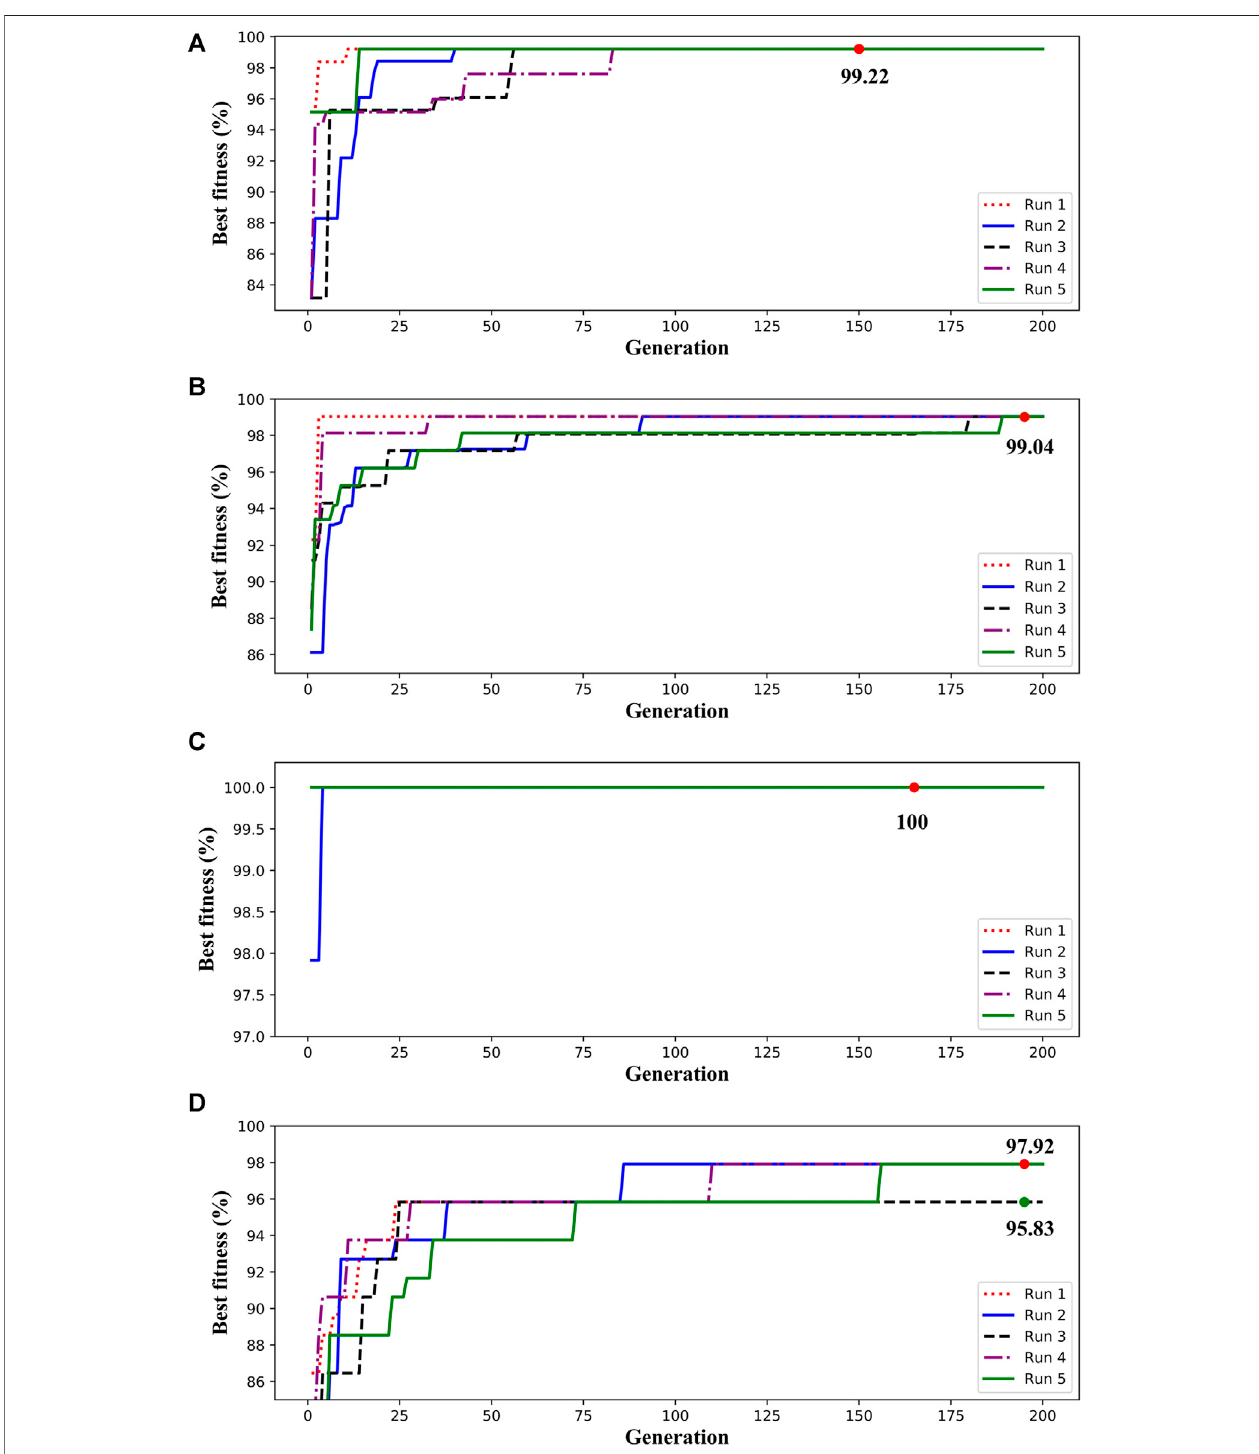
FIGURE5| Performanceofthetransformerfaultdiagnosissystemintrainingprocess, (A) isthebest fi tnesscurvesoftheIGA-XGBoost1forN-Fidenti fi cation, (B) is the best fi tness curves of the IGA-XGBoost2 for PD-D-T identi fi cation, (C) is the best fi tness curves of the IGA-XGBoost3 for D1-D2 identi fi cation, (D) is the best fi tness curves of the IGA-XGBoost4 for T1&2-T3 identi fi cation.